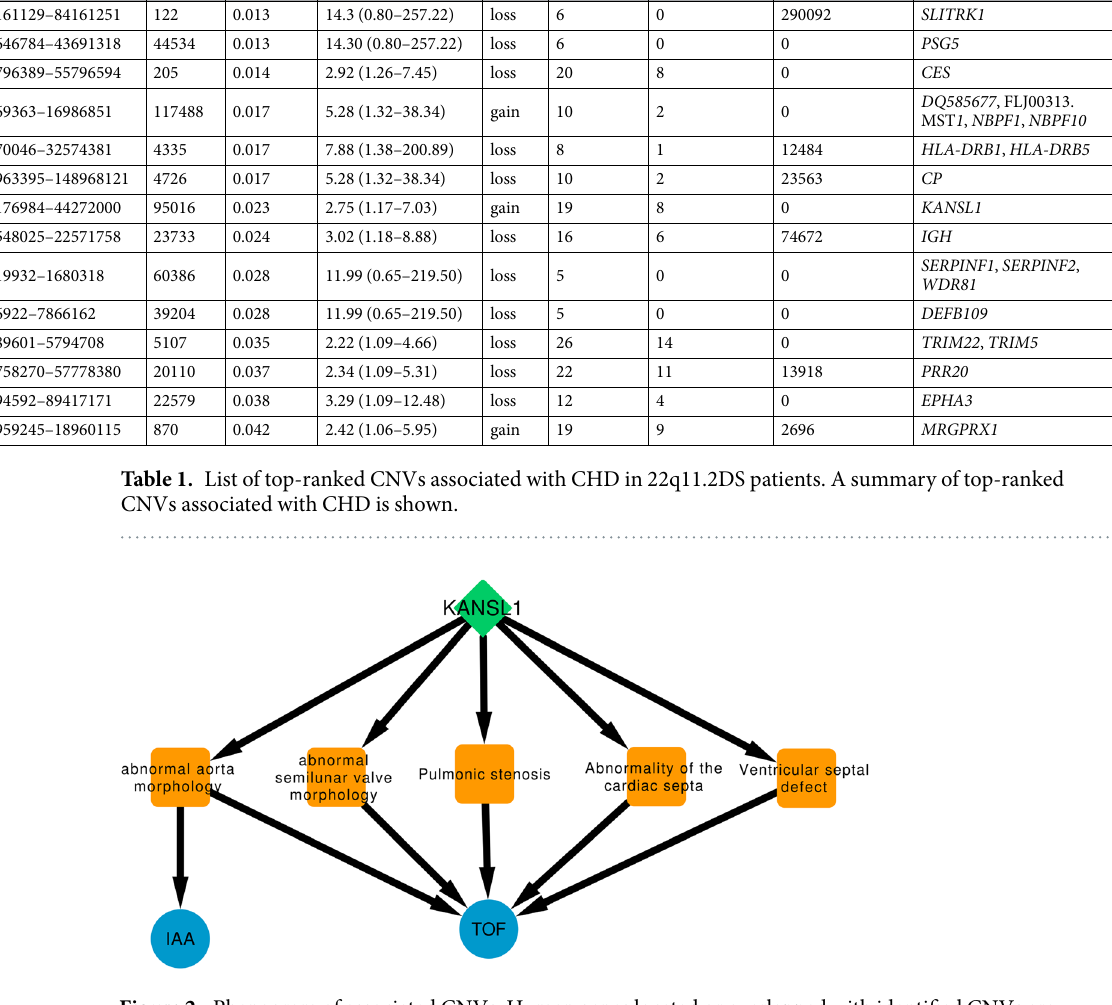
Figure 2. Phenogram of associated CNVs. Human genes located or overlapped with identified CNVs are showed as green diamonds, phenotypes found in the 22q11.2DS patients are displayed as blue circles and